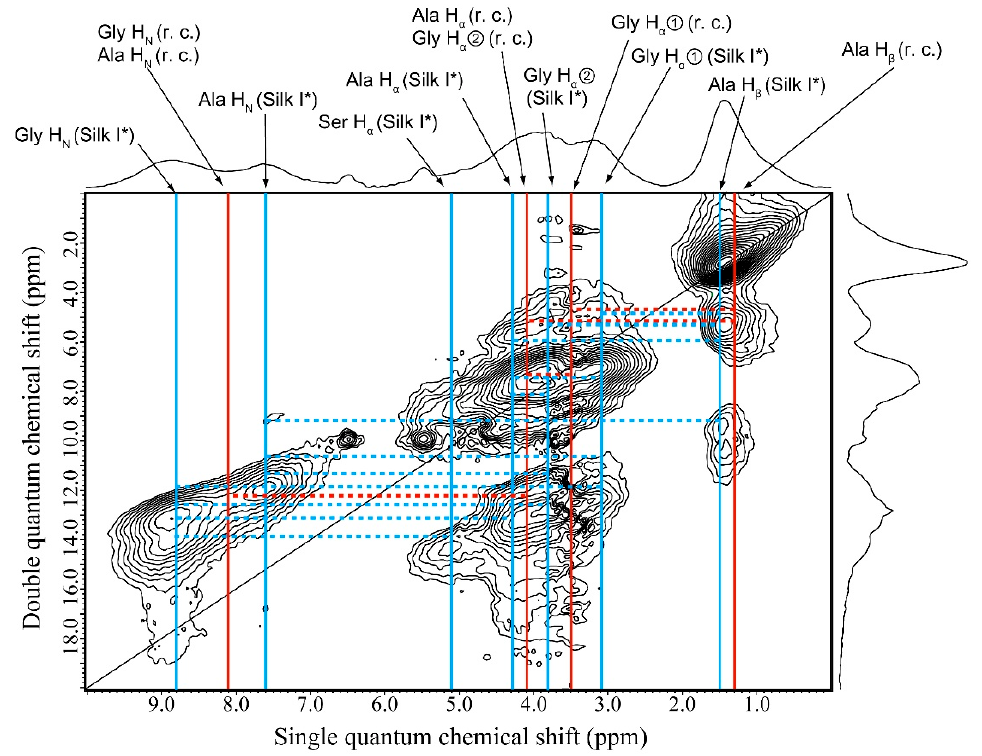
Figure 7. 1 H DQMAS NMR spectrum of Glyc (29 wt %)-blended SF film together with the assignments. The 1 H chemical shifts of random coil ( red ) and Silk I* ( blue ) forms are shown together with the 1 H– 1 H correlation signals (broken lines).